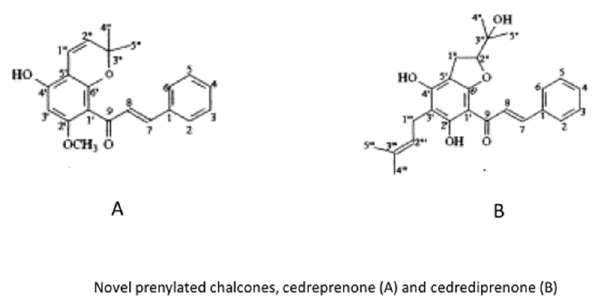
Figure 5. Specific prenylated chalcones isolated from Cedrelopsis grevei .